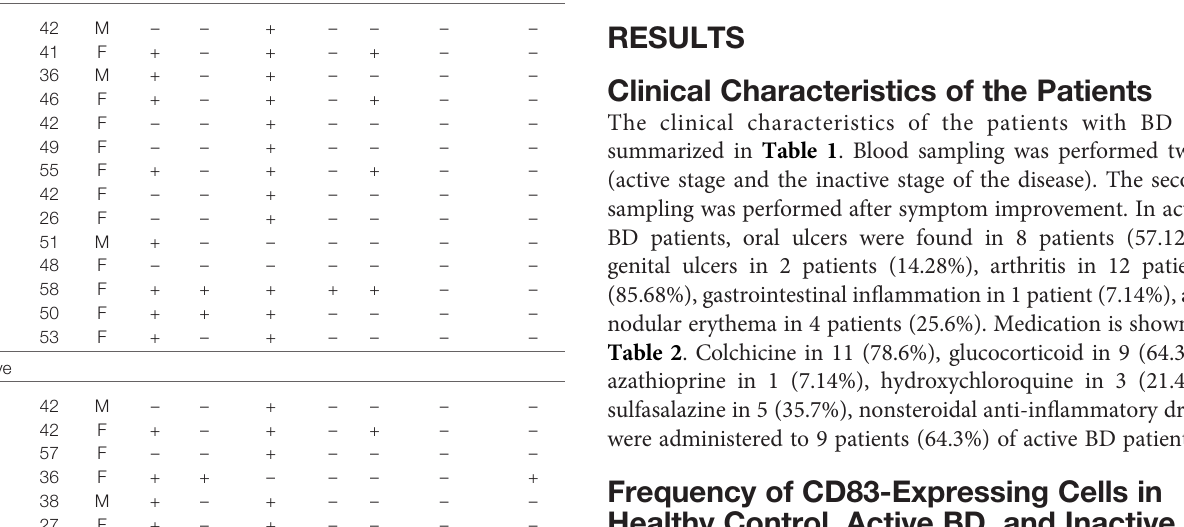
Table 2 . Colchicine in 11 (78.6%), glucocorticoid in 9 (64.3%),